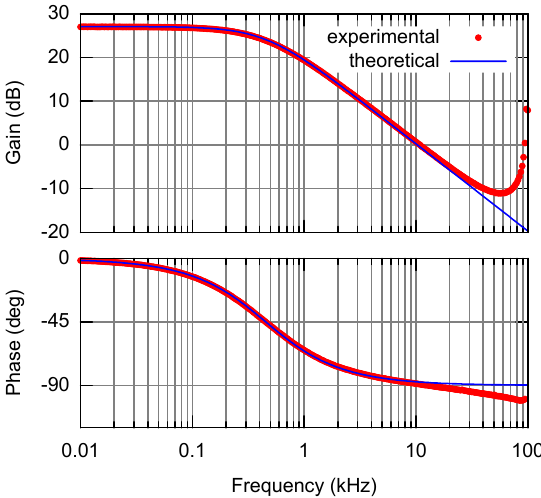
Figure 13. Theoretical and experimental frequency responses from current reference ˆ v ir to output voltage ˆ v o in the buck converter of Figure